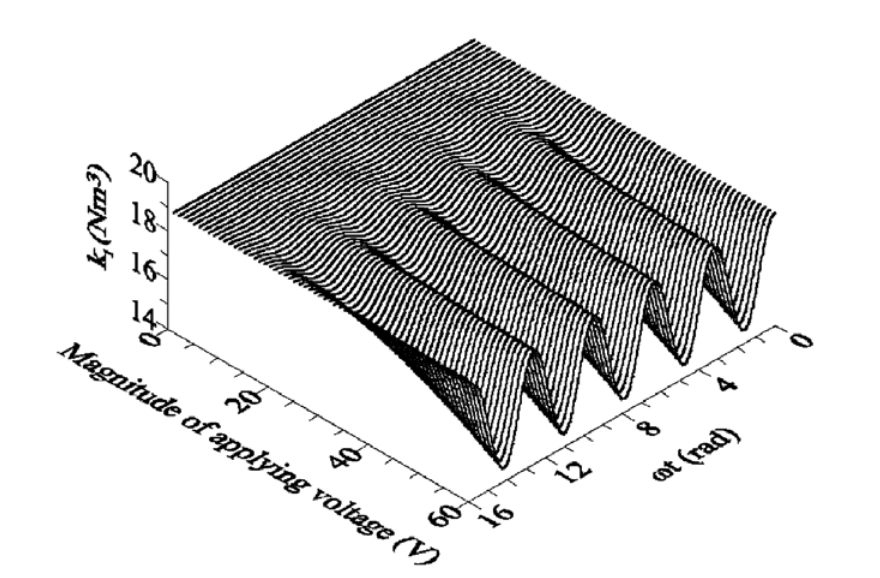
Figure 6. The first modal stiffness variation [80].